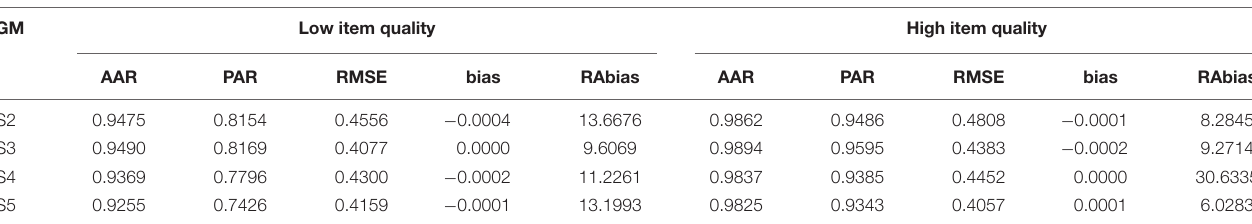
TABLE 5 | Summary of parameter recovery when data were fitted by S1.